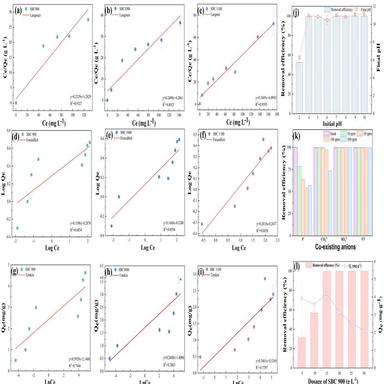
Phosphorus sorption by SBC 900: (a)~(c) Langmuir linear adsorption isotherm, (d)~(f) Freundlich linear adsorption isotherm, (g)~(i) Temkin linear adsorption isotherm, (j) effect of co-existing anions, (k) effect of pH, (l) effect of SBC 900 dosage. (25 ◦ C, rection time 24 h, dosage of ceramsite 20 g L− 1 , initial pH 7).